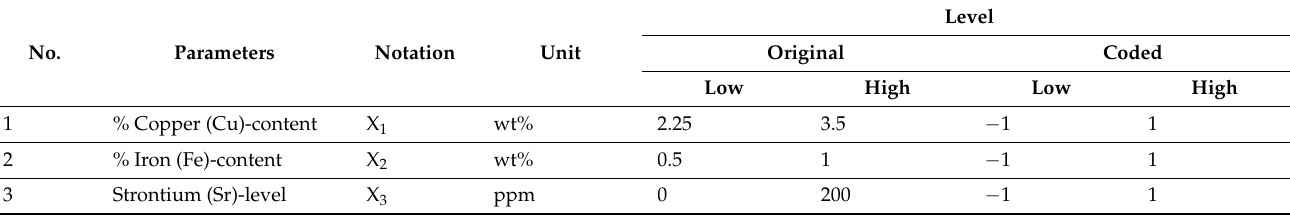
Table 1. Experimental settings for independent variables.